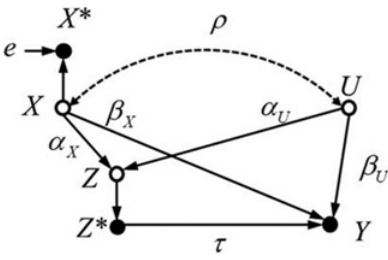
Figure 6: Causal graph for two correlated confounders X and U . The vacant nodes for X, Z and U indicate that they are unobserved. Z * is